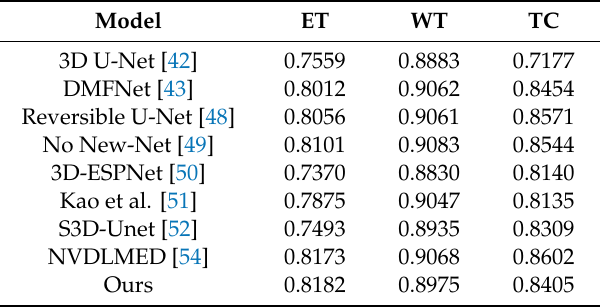
Table 3. The performance comparison of the dice score of di ff erent models on the BraTS2018 validation